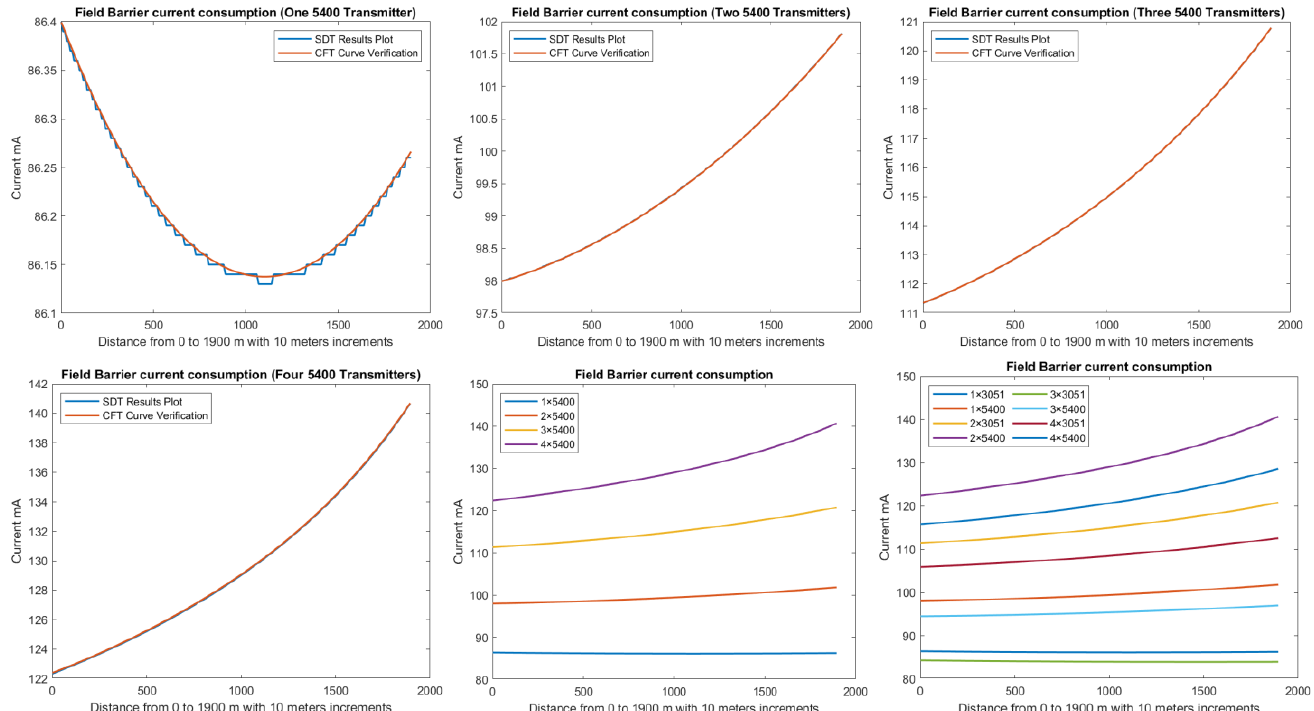
Figure 13. Illustration of current consumed by field barrier with respect to FF H1 trunk cable length when for four models in which one, two, three or four 3051 transmitters were connected to the field barriers in the models in Figure 6a.